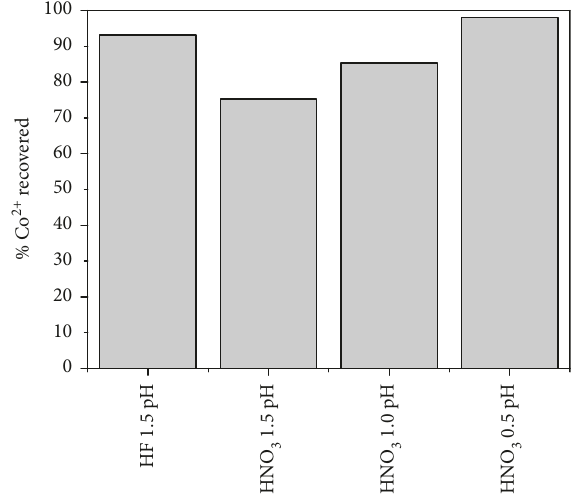
20mg/L, T 25 ° C, adsorbent (cid:30) (cid:30) powder, and 1100rpm. (cid:30)